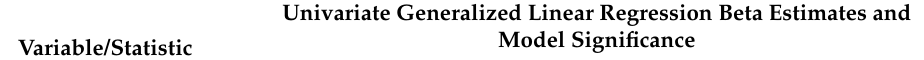
Table 8. Univariate GLM for the effect of EARN on